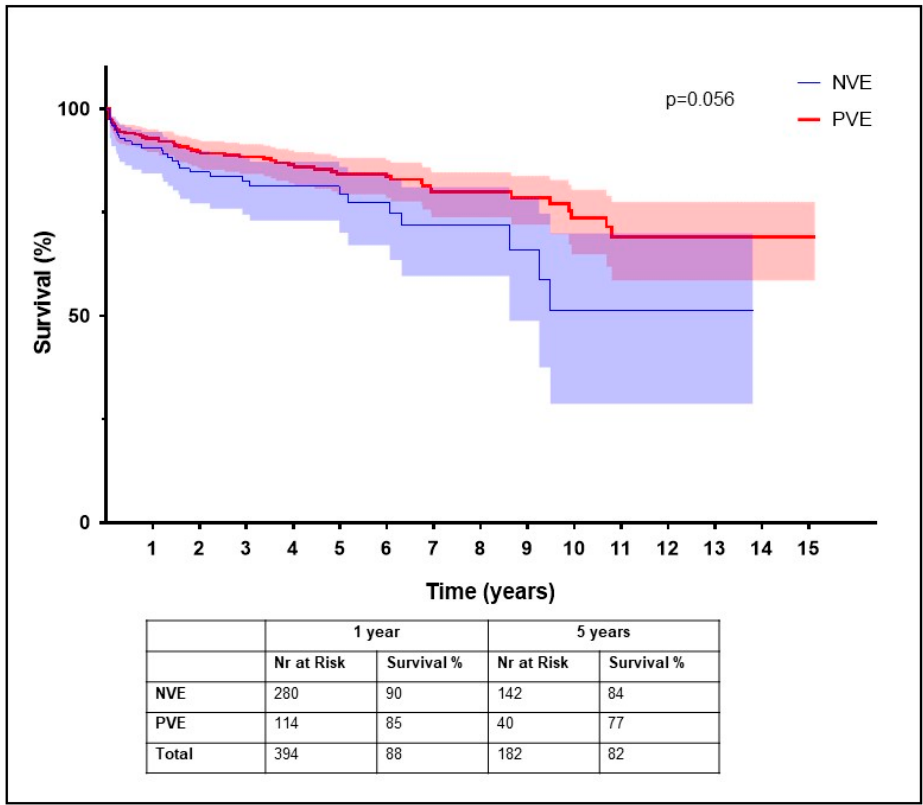
Figure 1. Kaplan–Meier survival curves for native valve endocarditis versus prosthetic valve endocarditis.